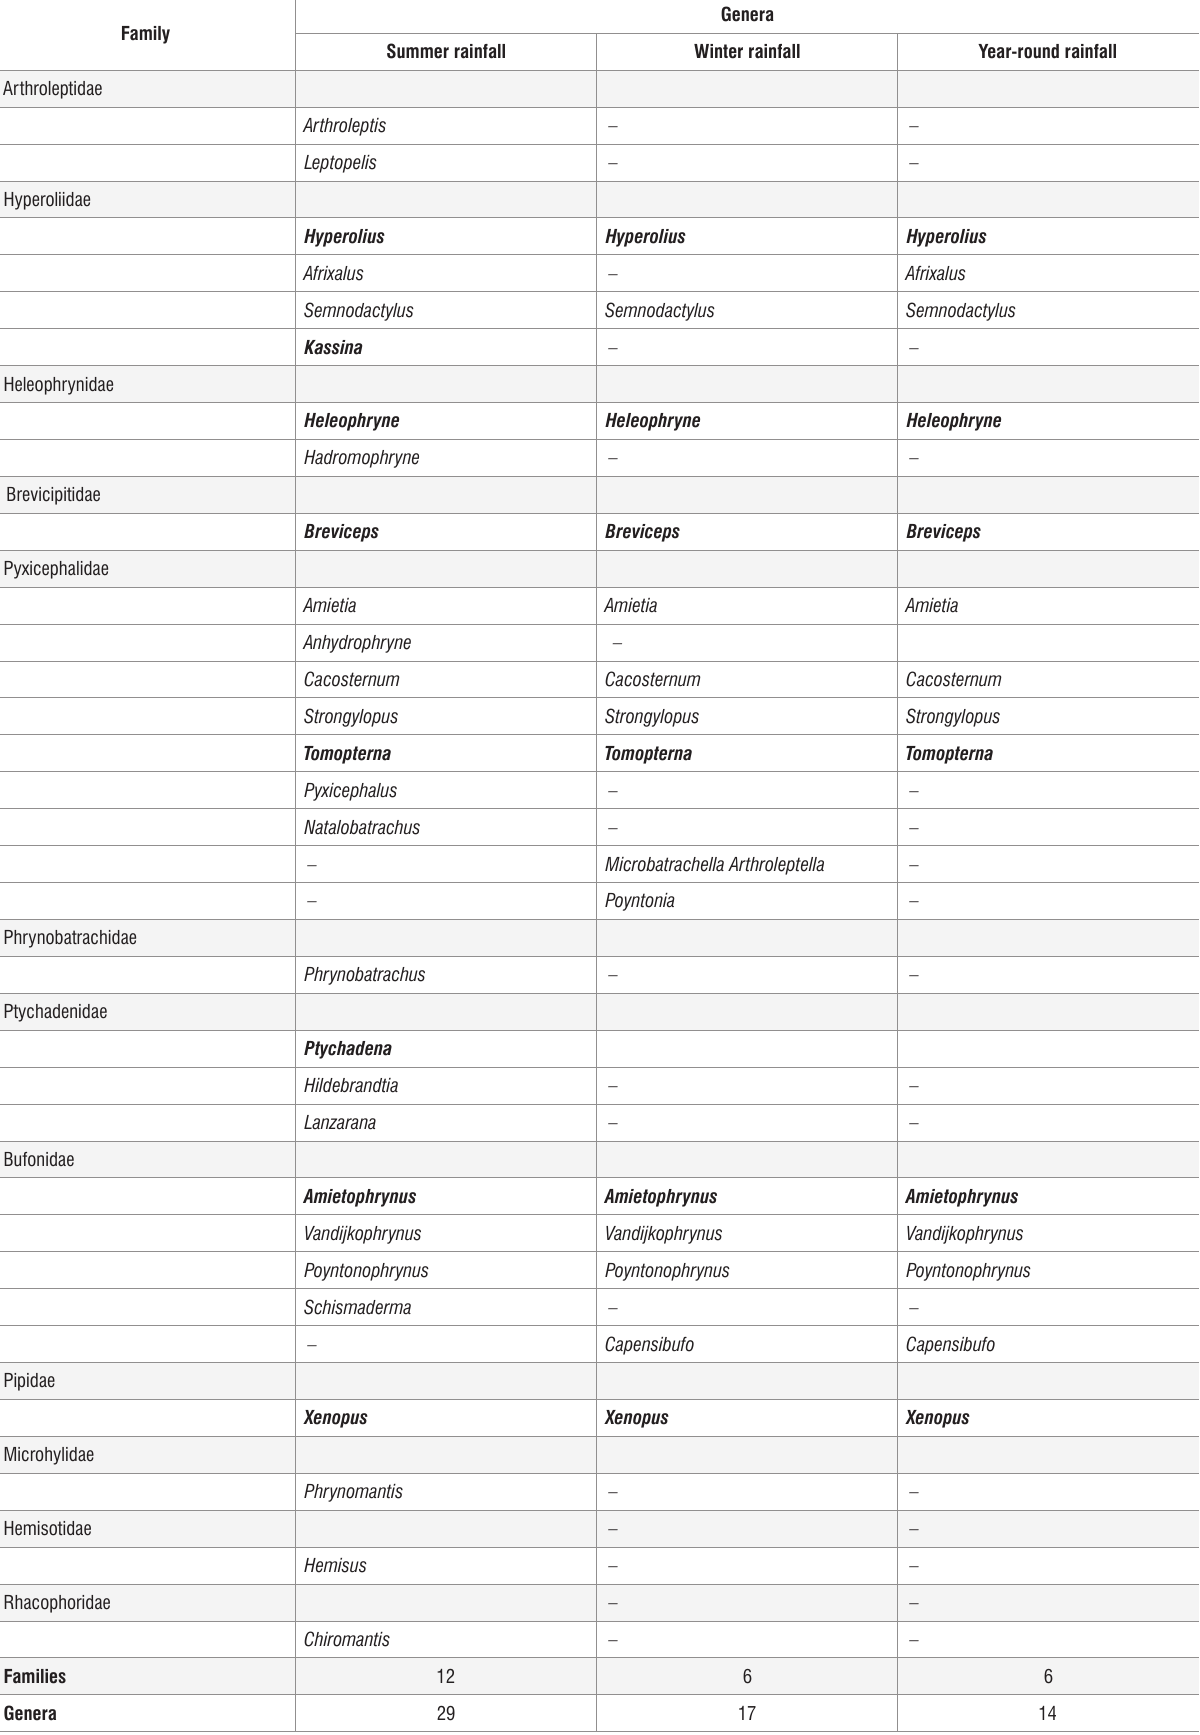
Table 1: Distribution of extant frog families and genera according to the current rainfall regime. Fossil taxa found at Langebaanweg are